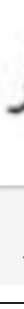
Figure 13: Atypical letter pattern (printing error?)